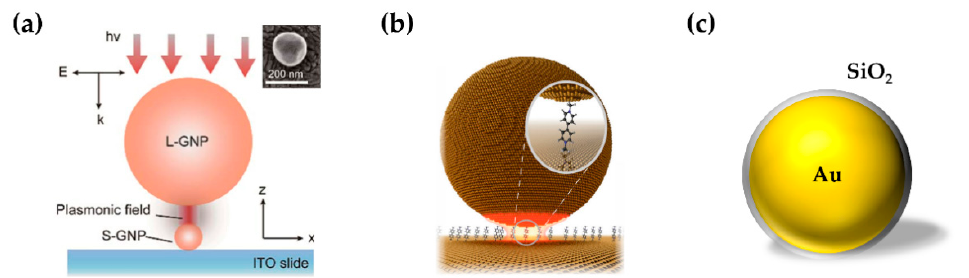
Figure 4. Monitoring of catalytic reactions by SM-SERS. ( a ) The Au dimers, consisting of two nanoparticles sized 200 nm and 13 nm. Figure reproduced from [95]. Inset: an SEM image of the Au dimers. L-GNP, large gold nanoparticles. S-GNP, small gold nanoparticles. ITO, indium tin oxide. ( b ) Self-assembled 80 nm NPoM for eliciting EF for SM-SERS. Figure reproduced from [96]. ( c ) SHINERS, Au core SiO 2 shell nanoparticles.